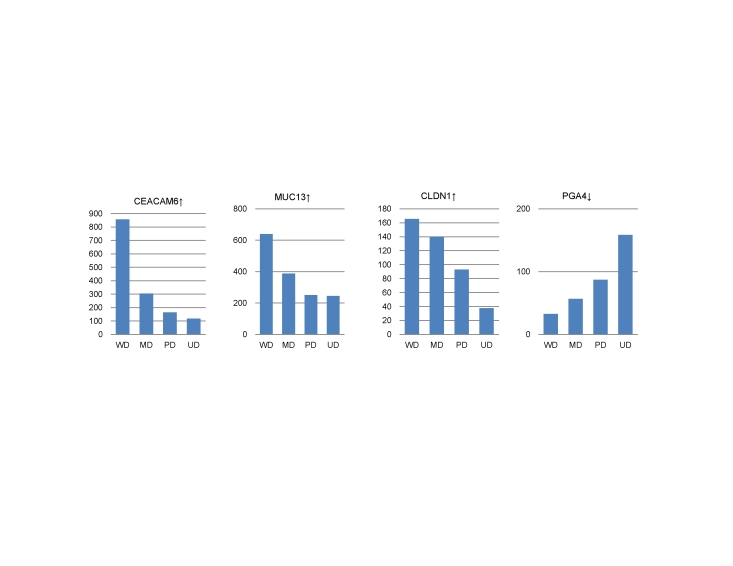
Correlation between gene expression levels and cancer grades of four genes.(“↑” and “↓” denote up- and down-regulation in cancer versus reference tissues, respectively.)